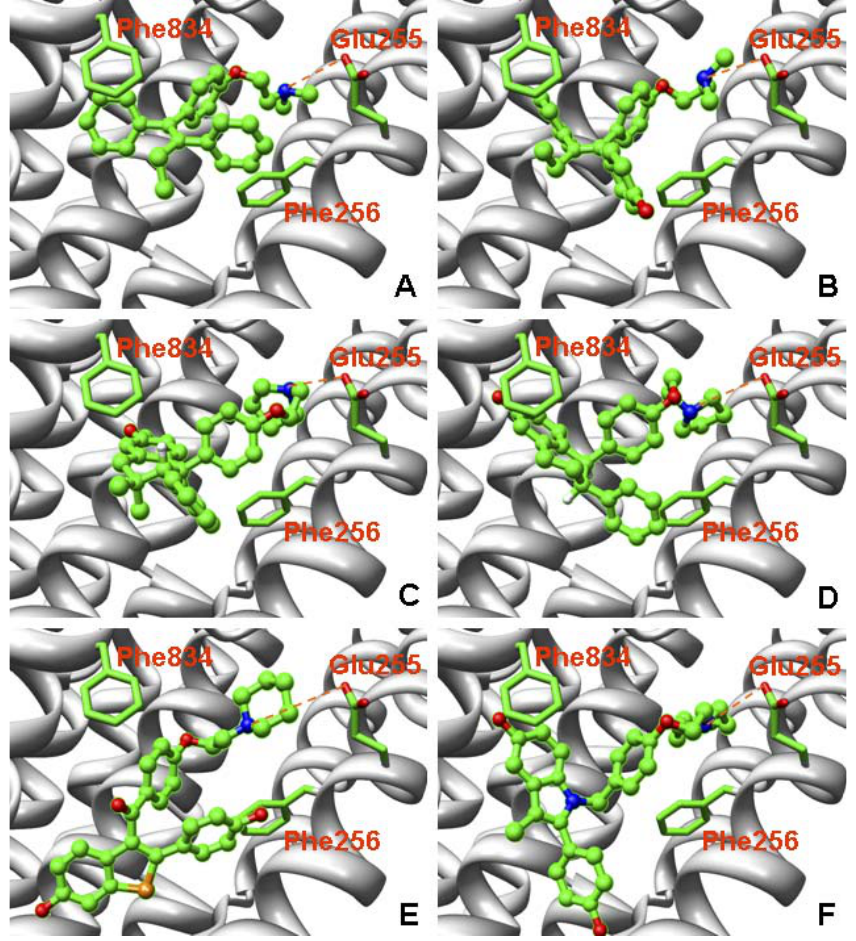
Figure 7. Docking Poses of Six SERMs at the SERCA TG1 Site (A) TAM, (B) OHT, (C) ORM, (D) LAS, (E) RAL, and (F) BAZ. SERCA is represented as a white backbone. Side chains of Phe256/834 and Glu255 are represented with stick models. SERMs are represented as ball and stick models. Carbon atoms are colored green; oxygens red; nitrogens blue; sulphur orange. The potential salt bridge interaction between the amine and Glu255 is indicated by an orange dashed line. doi:10.1371/journal.pcbi.0030217.g007 PLoS Computational Biology |